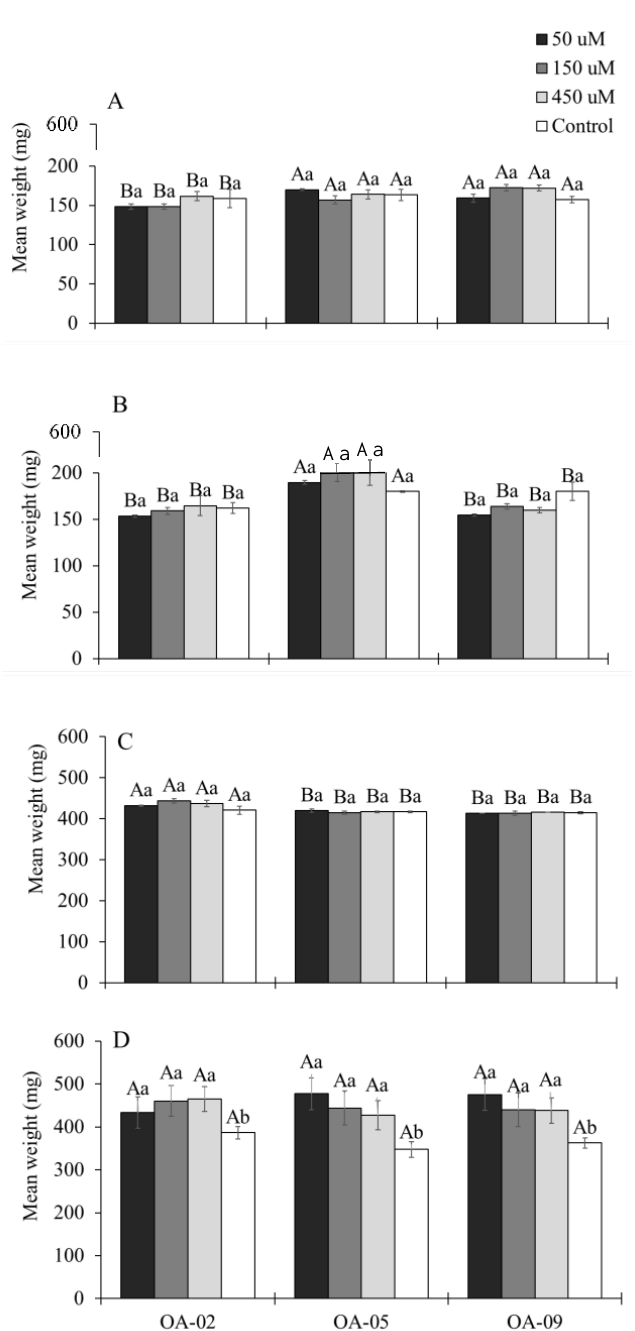
Figure 4. Effect of different concentrations of OA-02, OA-06 and OA-09 compounds on 3rd–5th instar H. armigera larval ( A – C ) and pupal weights ( D ). The data were subjected to a 2-way ANOVA (statistics for the effects of compound type for 3rd–5th instar larval weight and pupal weight: F 2, 24 = 4.301; p = 0.025, F 2, 24 15.552; p < 0.001, F 2, 24 = 20.407; p < 0.001 and F 2, 24 = 0.156; p = 0.856, respectively while the statistics for the effect of their concentrations: F 2, 24 = 1.003; p = 0.408, F 2, 24 = 0.904; p = 0.454, F 2, 24 = 1.083; p = 0.375 and F 2, 24 = 5.640; p = 0.005, respectively). The bars represent mean ± SEM and the superscript uppercase and lowercase letters atop each bar represent the post-hoc pairwise comparisons between different compounds and concentrations, respectively. The bars with different letters are significantly different from each other ( p <